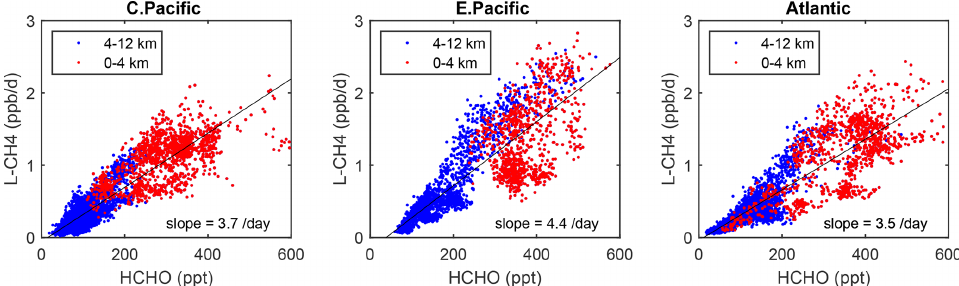
Figure 6. Scatterplot of L-CH4 (ppbd − 1 ) versus HCHO (ppt) for ATom 1 in the three tropical regions shown in Fig. 3. The air parcels are split into the lower troposphere (0–4km pressure altitude, red dots) where most of the reactivity lies and middle–upper troposphere (4–12km, blue). A simple linear fit to all data is shown (thin black line), and the slope is given in units of